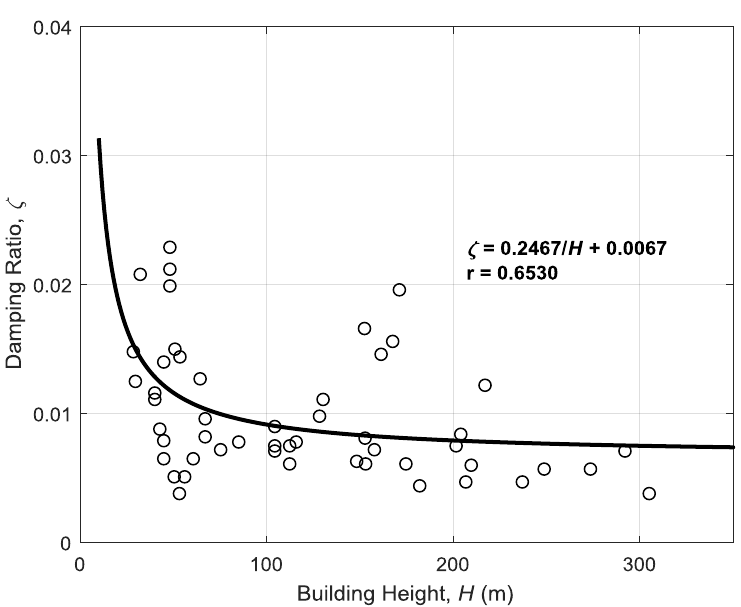
Figure 10. Regression analysis of measured damping ratio.